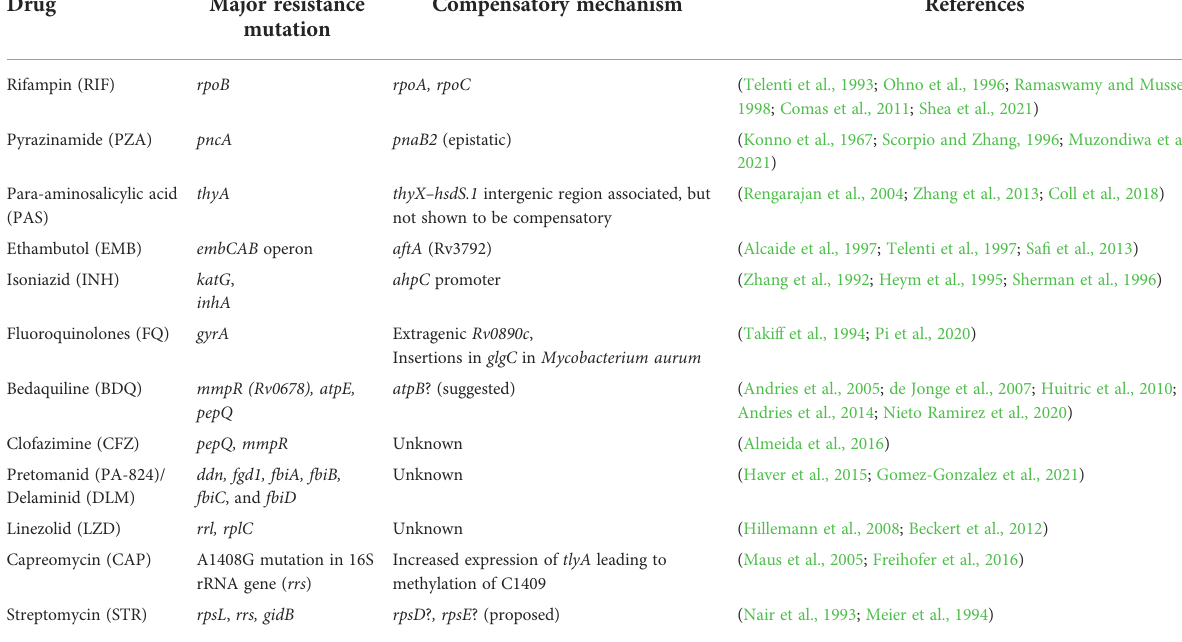
TABLE 1 Examples of resistance mutations and compensatory mechanisms in